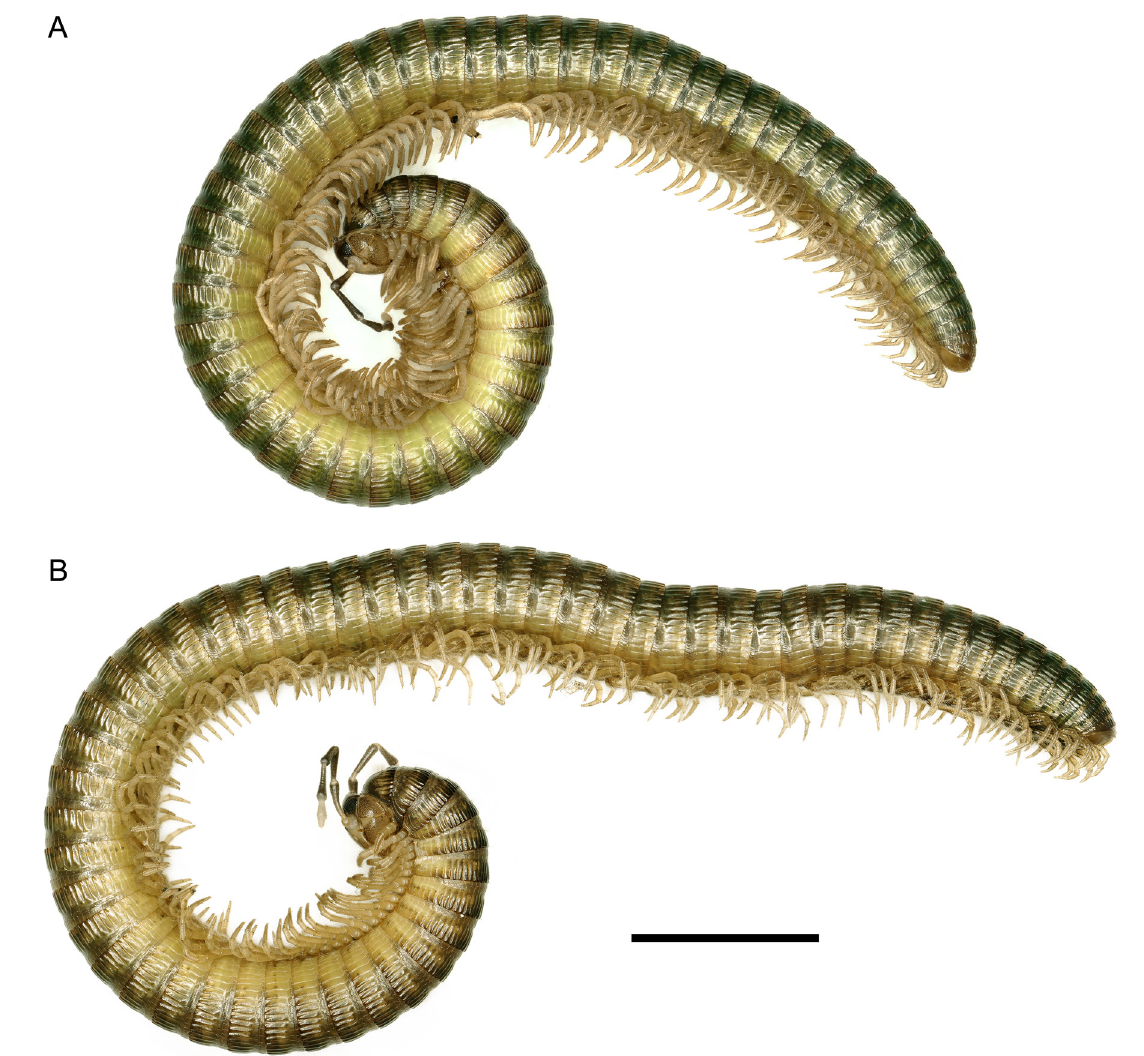
Fig. 2. External morphology of Lusitanipus xanin sp. nov. in lateral view. A . ♂ holotype (MNCN 20.07/2069). B . ♀ paratype (MNCN 20.07/2070). Scale bar = 5